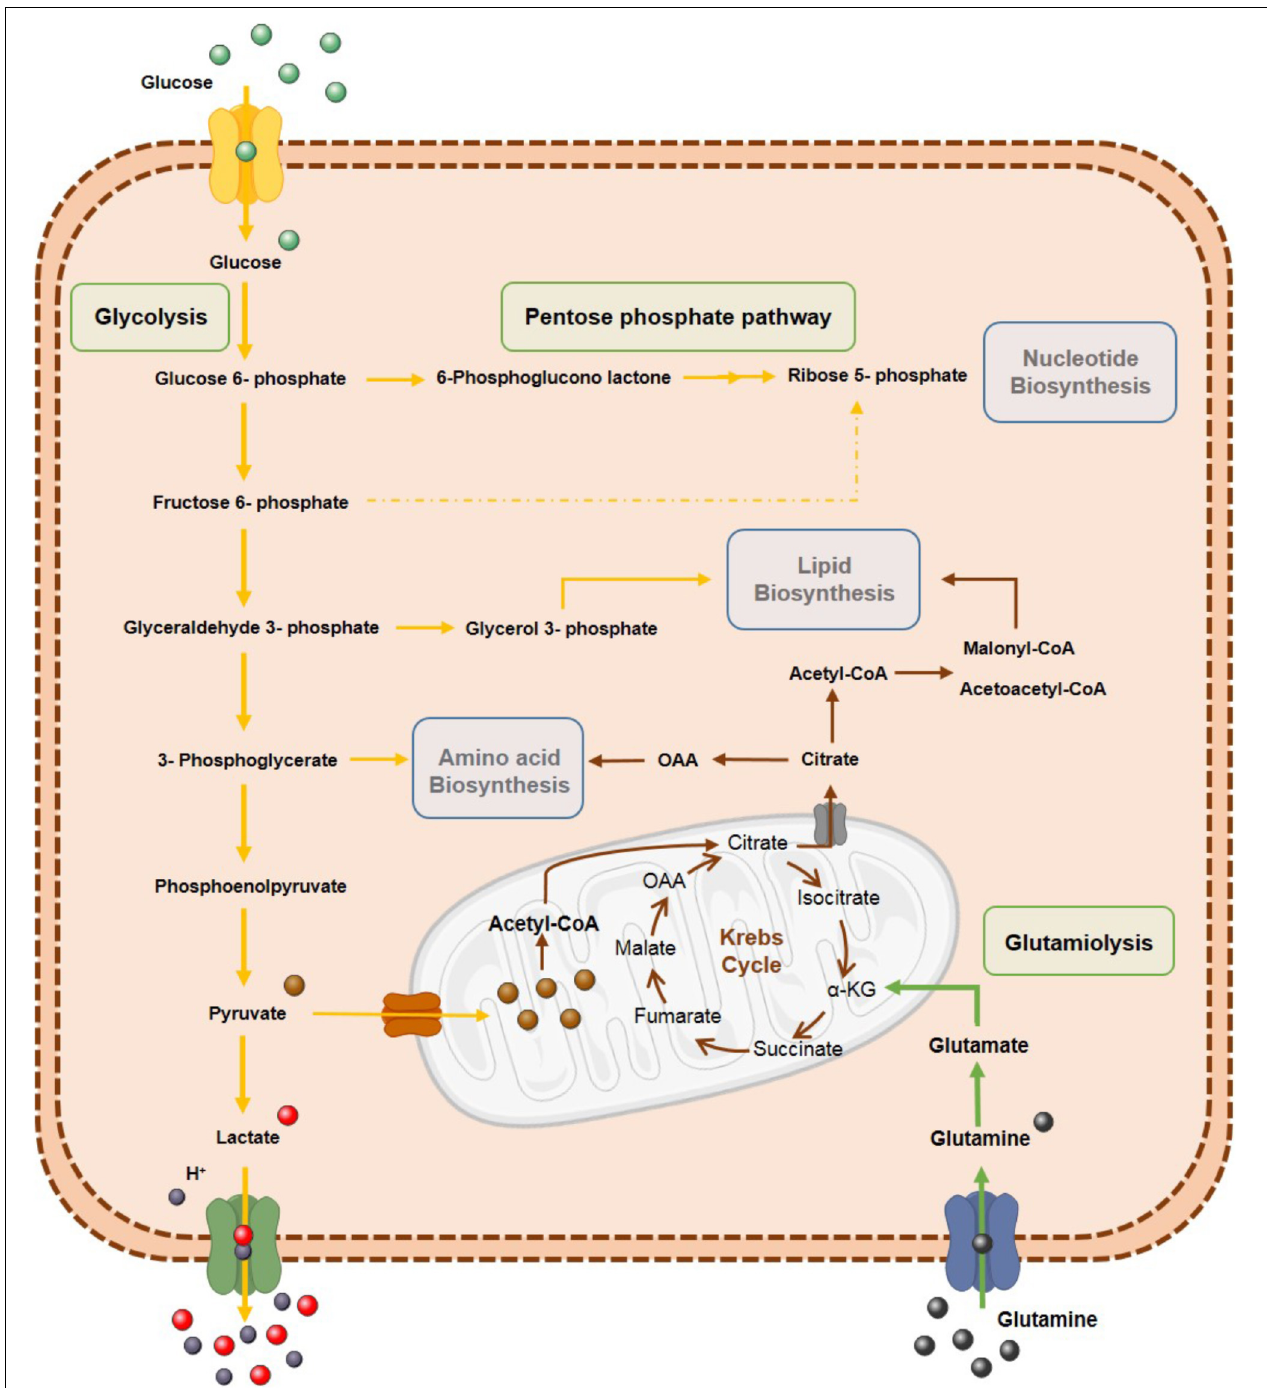
FIGURE 2 | Tumor cells’ metabolism reprogramming. Metabolic reprogramming of tumor cells is characterized by highly glycolytic rates to increase tumor biomass by biosynthetic process. Glycolytic intermediates are used in pentose phosphate pathway (PPP) for anabolic process such as biosynthesis of nucleotides, amino acids and lipids. Glutamine is also an important source for tumor cells through glutaminolysis.